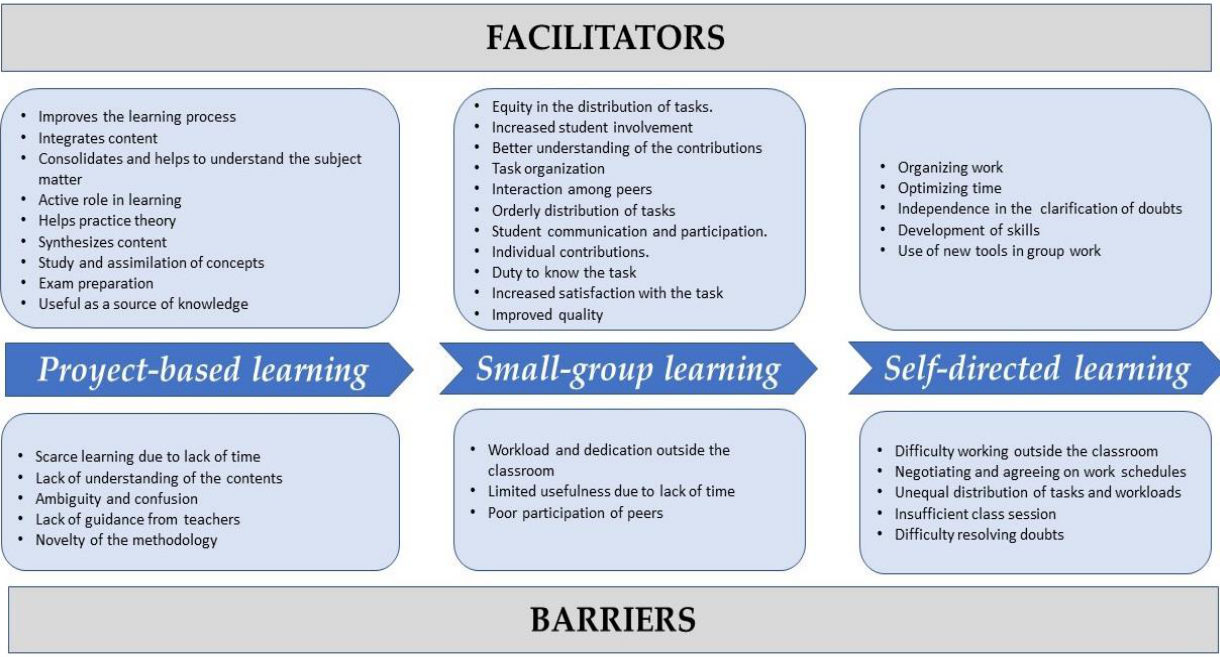
Figure 2. Identified facilitators and barriers.